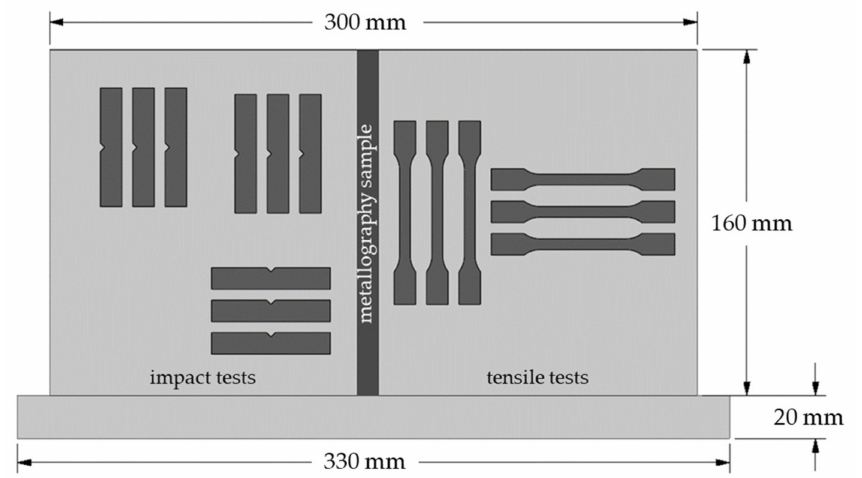
Figure 4. Layout of samples for mechanical testing of an additively manufactured wall structure.